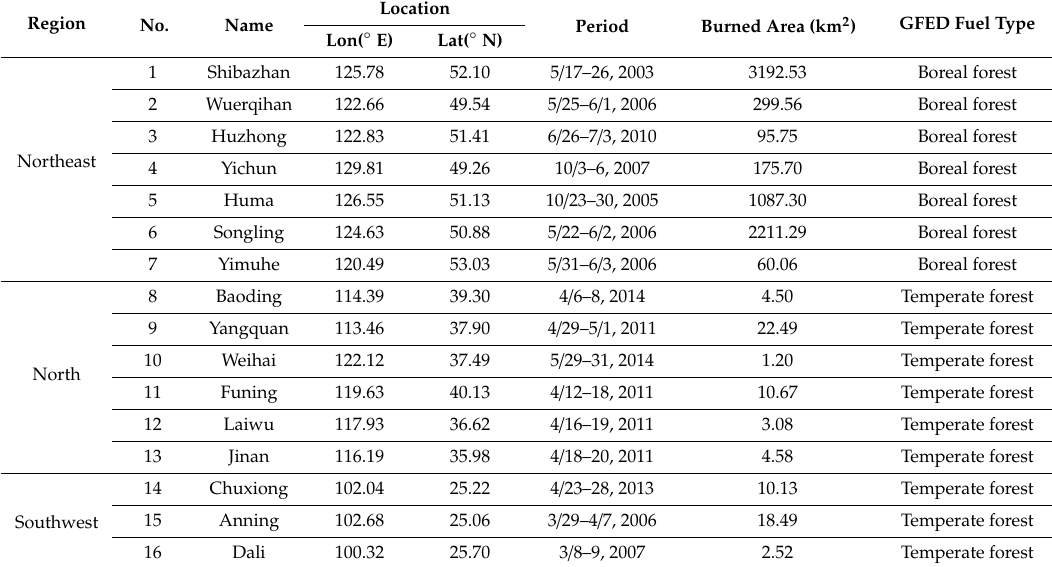
Table 1. Fire cases for smoke